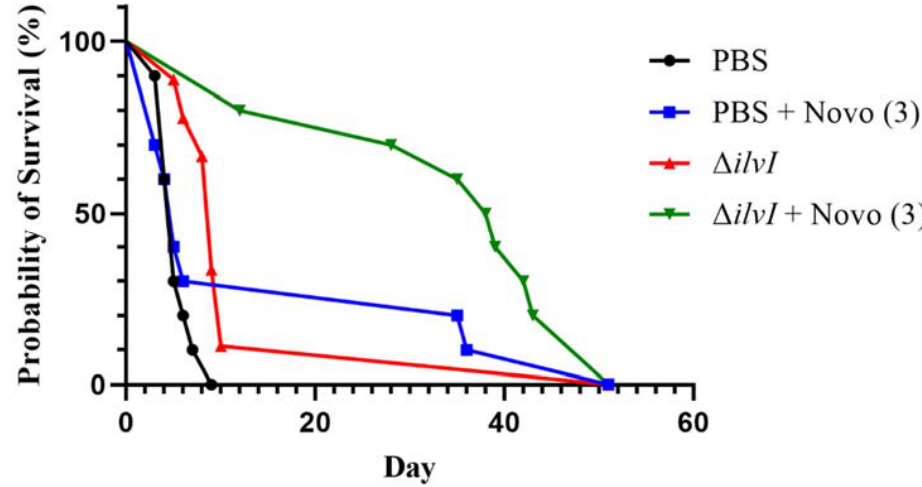
Figure 4. The protective effects for BALB/c mice exposed to aerosolized B. pseudomallei by vaccination with a live Burkholderia vaccine strain and treatment with Novo. The mice were vaccinated with the live attenuated B. thailandensis E555 ∆ ilvI strain, exposed to B. pseudomallei K96243, and then treated with 3 doses of 2.5 mg Novo at 1 h, 8 h, and 24 h post-challenge. The three control groups were vaccinated only, treated only, or were given PBS alone. The vaccinated mice received 2 doses of live vaccine via SC injection on day 0 and day 21, and the vaccine doses were 7.34 × 10 6 and 5.92 × 10 6 CFU, respectively. The mice were exposed to an inhaled dose of approximately 201 CFU of B. pseudomallei K96243 (8 LD 50 ) 28 days later. All groups had 10 mice except the vaccinated, untreated group contained 9 mice.